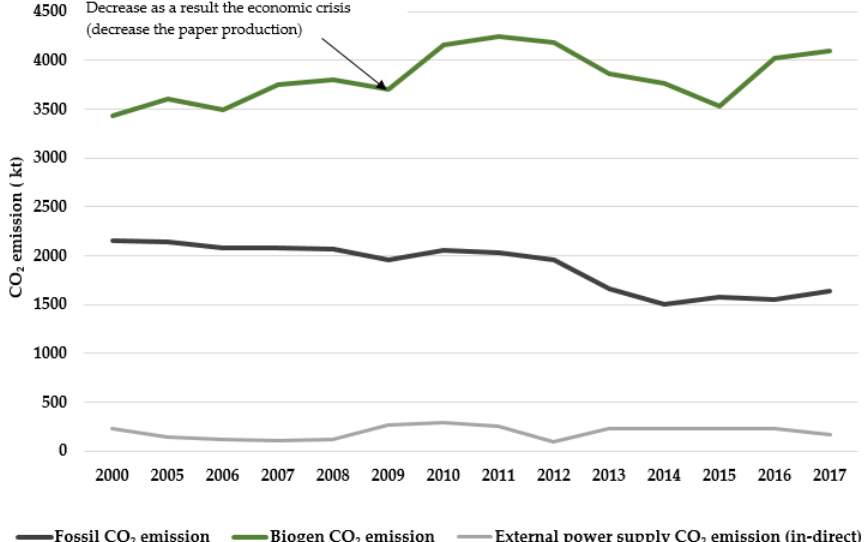
Figure 5. Historical trend of CO 2 emission in the P&P industry in Austria 2000–2017 [9,29,31–33].